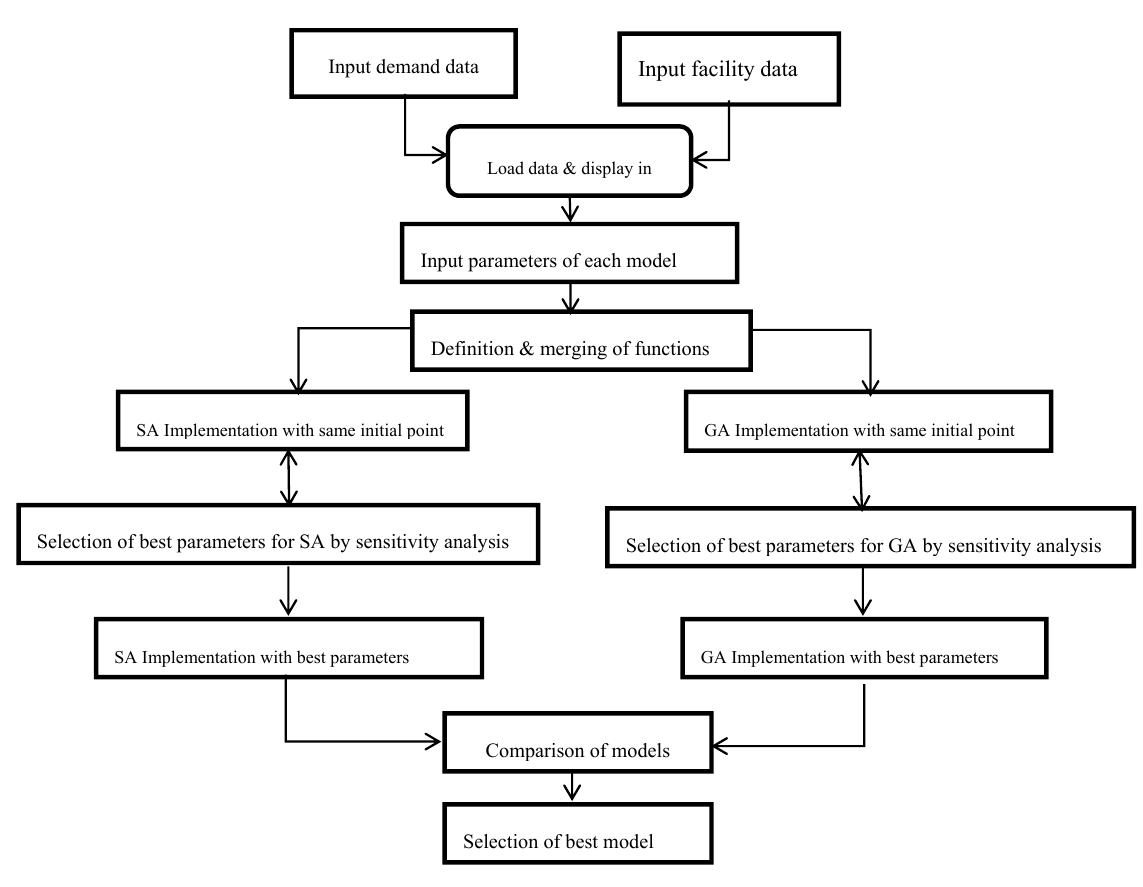
Figure 1. Methodological procedure.